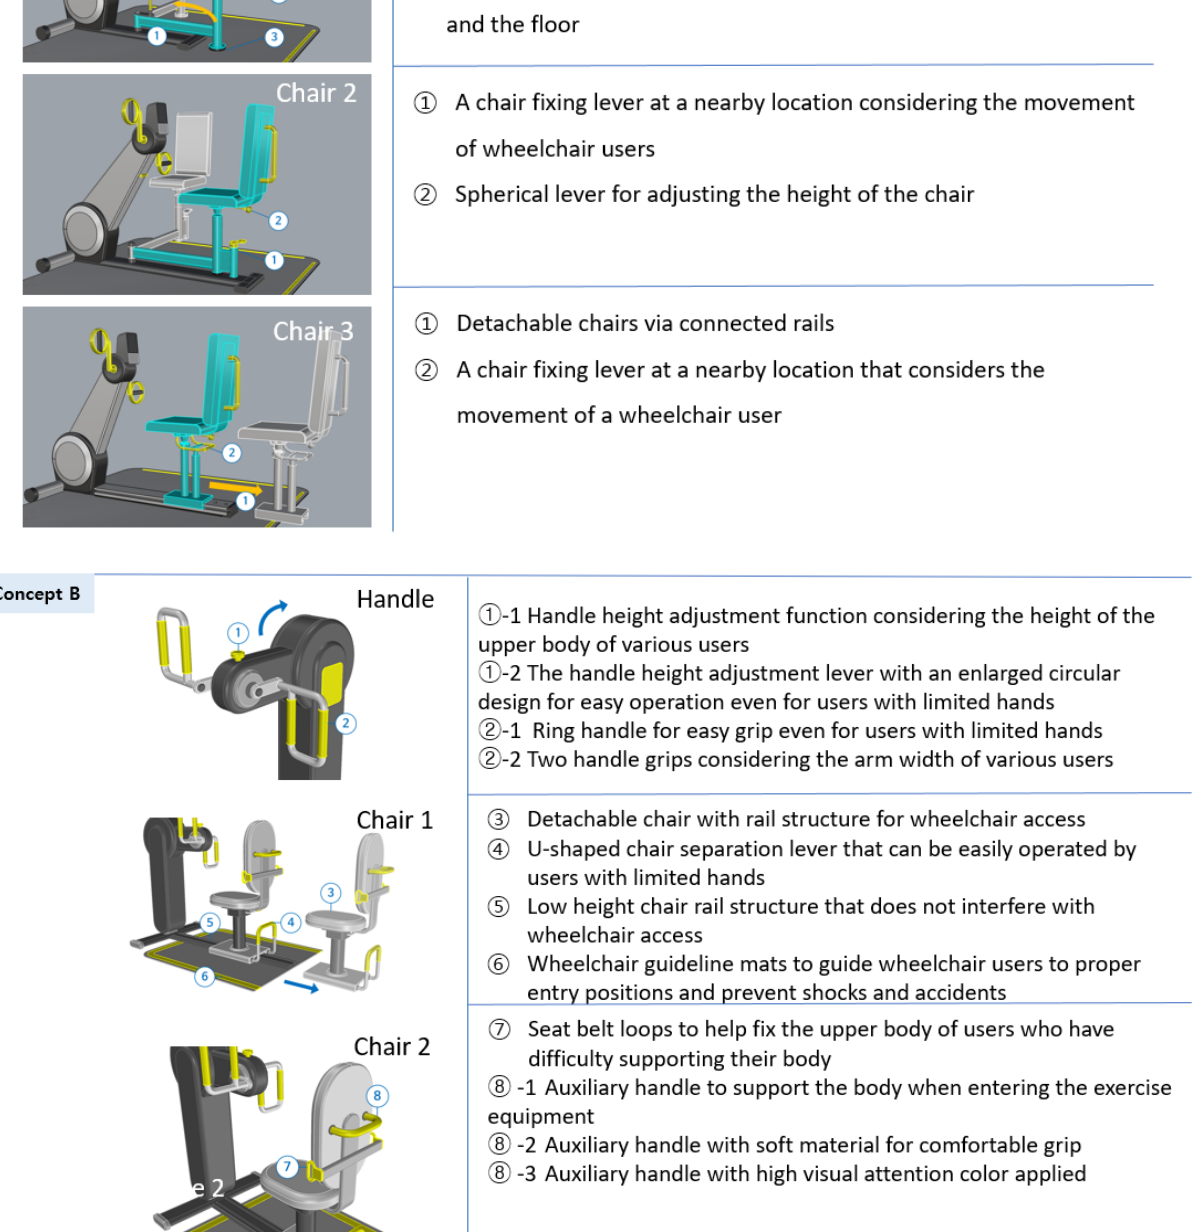
Figure 10. First 3D modeling of the arm ergometer design applying UD .